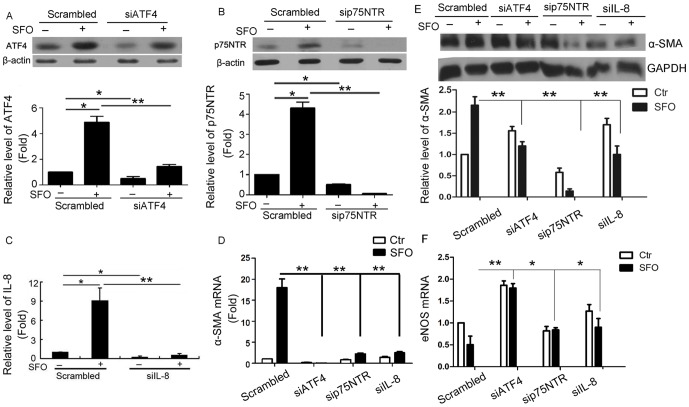
ATF4, p75NTR and IL-8 participated in SFO-induced EndoMT in HUVECs.Cells were preincubated with 40 nM ATF4, IL-8 or 60 nM p75NTR siRNA or scramble siRNA for 48 h, then 50 µg/ml SFO for 3 h for qPCR and 6 h for western blot assay. (A and B) Western blot analysis of siRNA-mediated downregulation of ATF4 and p75NTR in HUVECs. Data below the western blot bands were used to quantify the density of the bands. (C) qPCR analysis of siRNA-mediated downregulation of IL-8. GAPDH was a normalization control. (D and E) Analysis of effect of ATF4, p75NTR and IL-8 siRNA on SFO-induced α-SMA in HUVECs by qPCR (D) and western blot (E). (F) qPCR analysis of siRNA effects on eNOS expression in HUVECs. Expression was normalized to that of GAPDH. (*p<0.05, **p<0.01, n = 3).